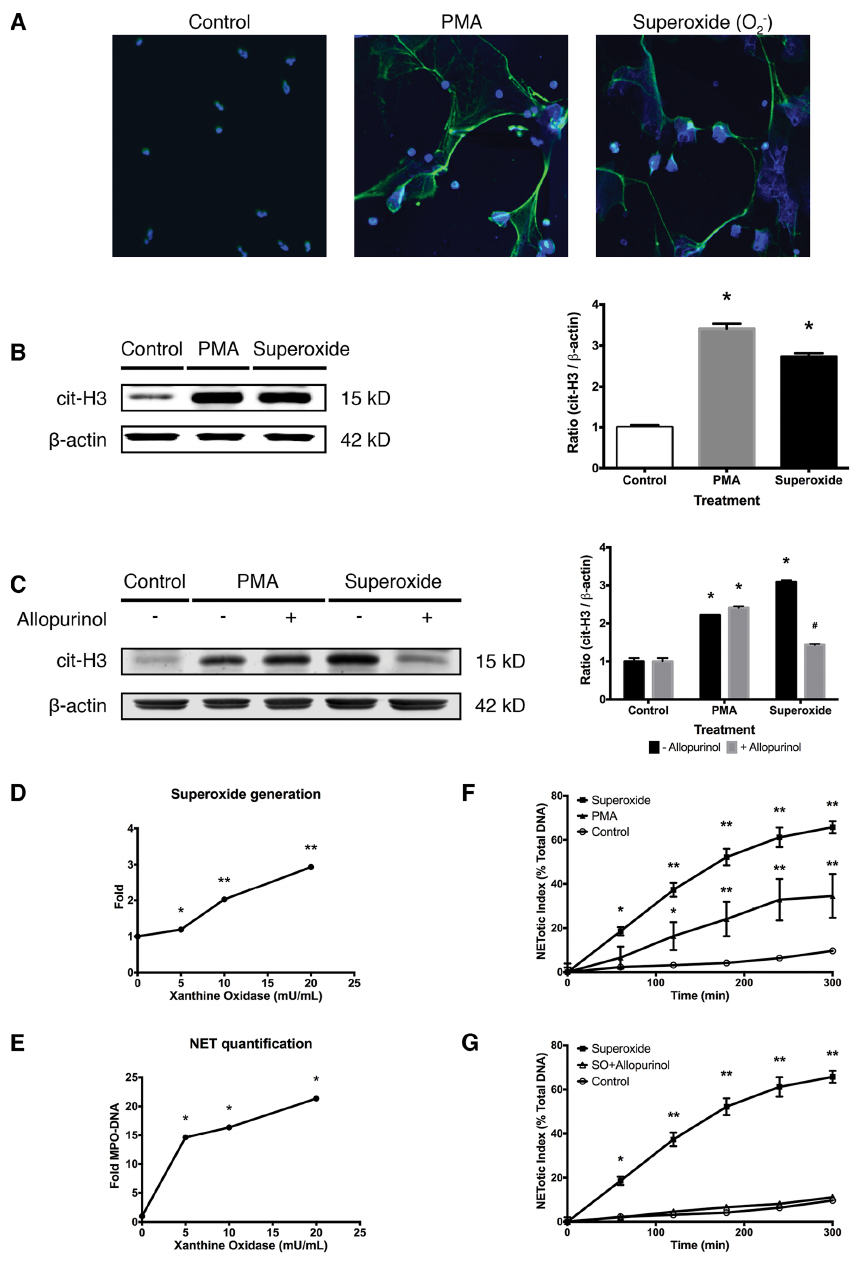
figure 1. Extracellular xanthine oxidase–derived superoxide induces NETs. (A) Neutrophils were incubated with media alone (negative control), PMA (100 nM), or xanthine oxidase (10 mU/mL) and hypoxanthine (500 nM) to yield superoxide, for 1–8 h at 37°C. Cells were then fixed, immunolabeled with antibody to citrullinated Histone H3, detected with a conjugated fluorescent secondary antibody (green), then stained for DNA with Hoechst (blue). (B) Western blot of citrullinated Histone H3 in neutrophils following treatment as above, or (C) with or without the competitive xanthine oxidase inhibitor allopurinol. β -actin is shown as a loading control. Densitometric quantification charts show mean ± SEM cit-H3 to β -actin, expressed as fold over control. (D) Assay of superoxide generated, and (E) NET MPO-DNA complexes formed in media by xanthine oxidase (0, 5, 10 or 20 mU/mL) and hypoxanthine (500 nM) after 8 h at 37°C. Shown as mean fold over control. (F) NET formation kinetics in response to superoxide or PMA as measured by a fluorescent plate reader assay for extruded DNA fibers (n = 8). (G) Allopurinol inhibits superoxide-induced NET formation. NET release is expressed as percentage of total DNA (n = 8). * p < .05 vs control; # p < .05 vs superoxide treatment; ** p < .001 vs control. All figures represent at least 3 independent experiments for each